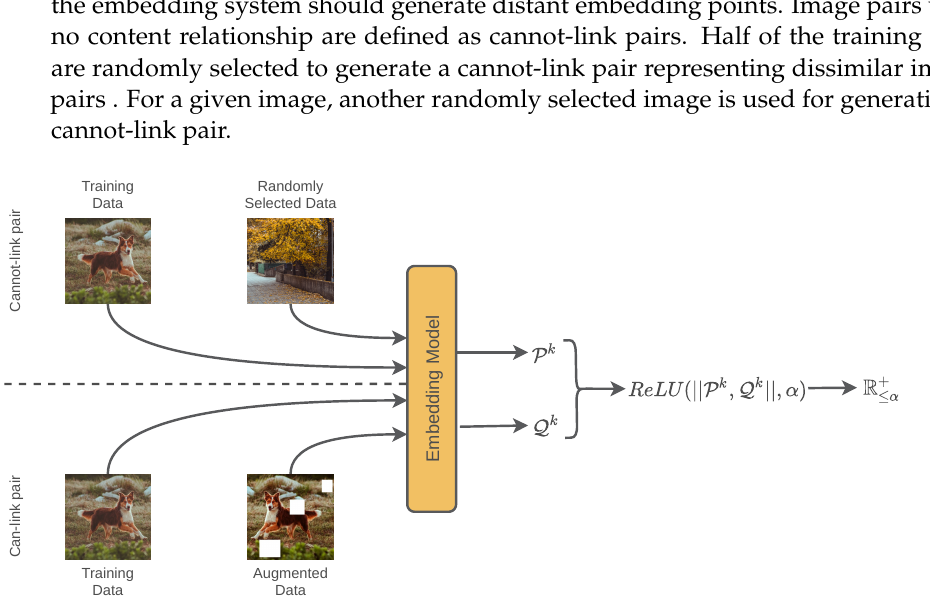
Figure 2. The AutoEmbedder framework generates a twin network for a given model. The objective is to calibrate the euclidean distance of the output pair of the twin network based on the image similarity and dissimilarity. For similar and dissimilar images, the output distance of the twin network should be 0 and α ,